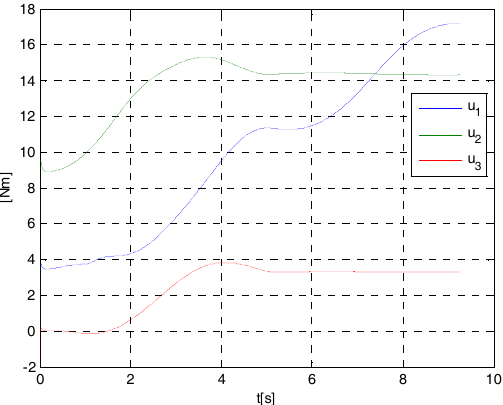
Figure 20. Time histories of the control torques with the controller (68).